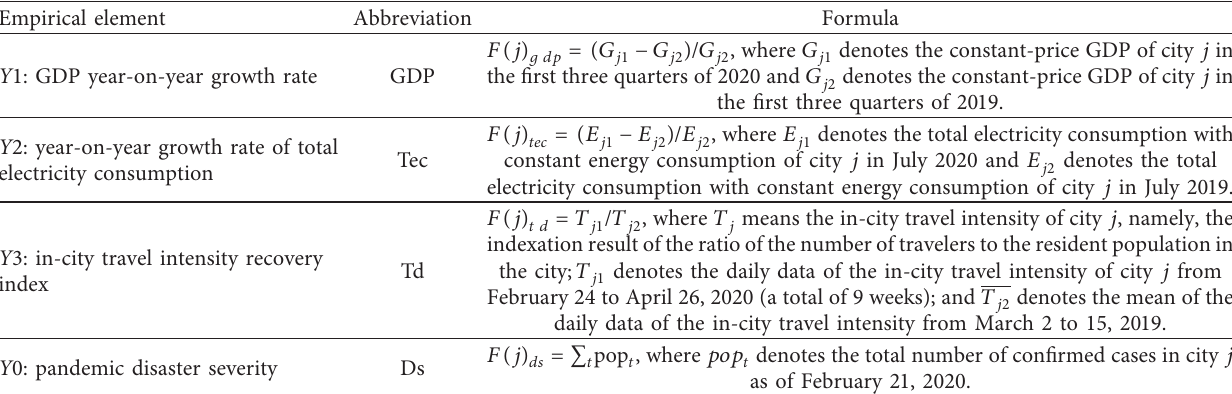
Table 1: Empirical elements of the urban resilience level.